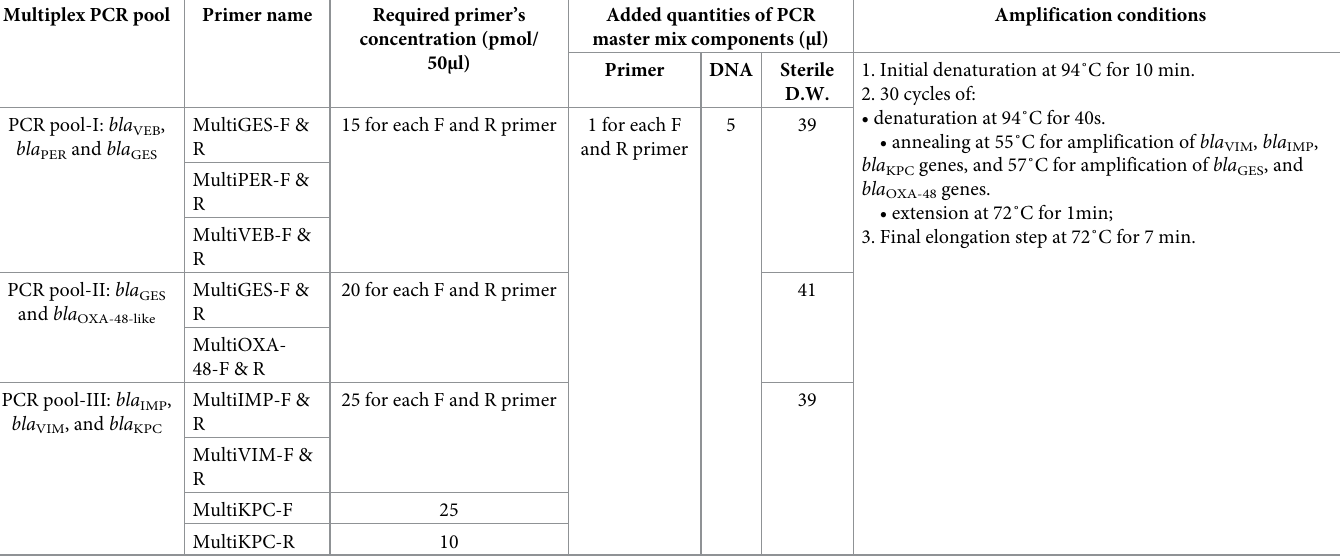
Table 4. Components of multiplex PCR master mix for the detection of carbapenemase genes (final volume 50 μ l) and amplification conditions [31]. Multiplex PCR